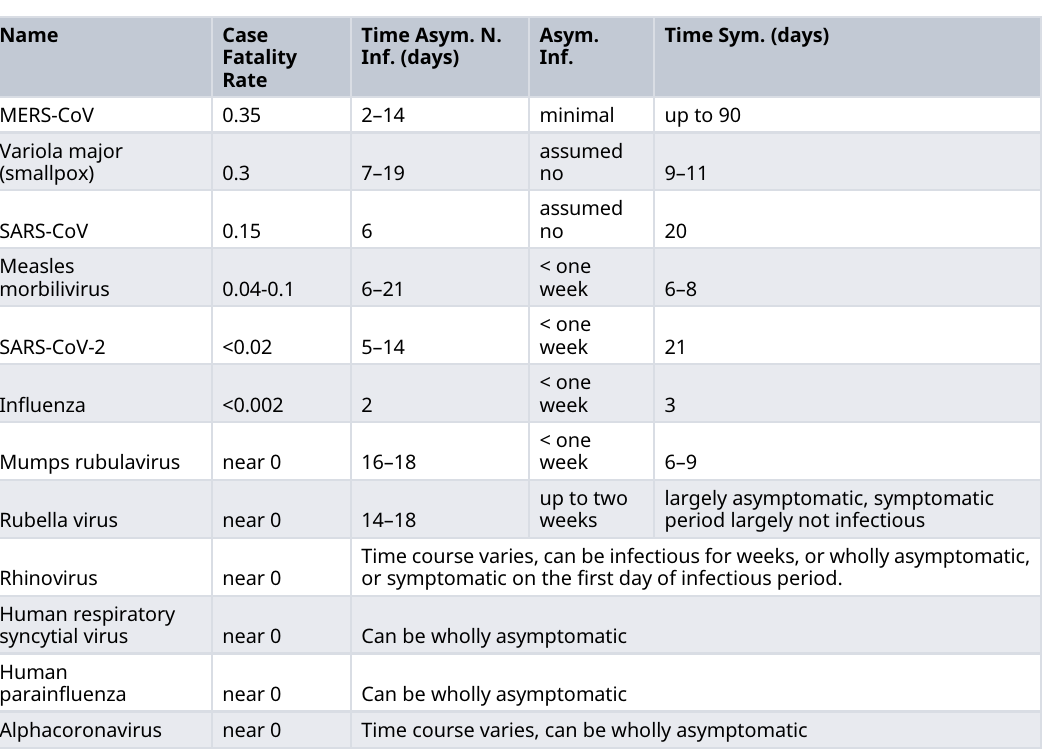
Table 2. Human respiratory viruses with substantial health